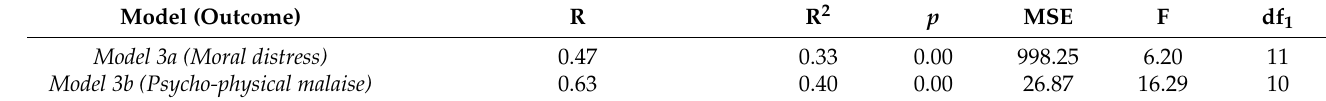
Table 7. Path coefficients and direct and conditional effects for the moderated mediation model.